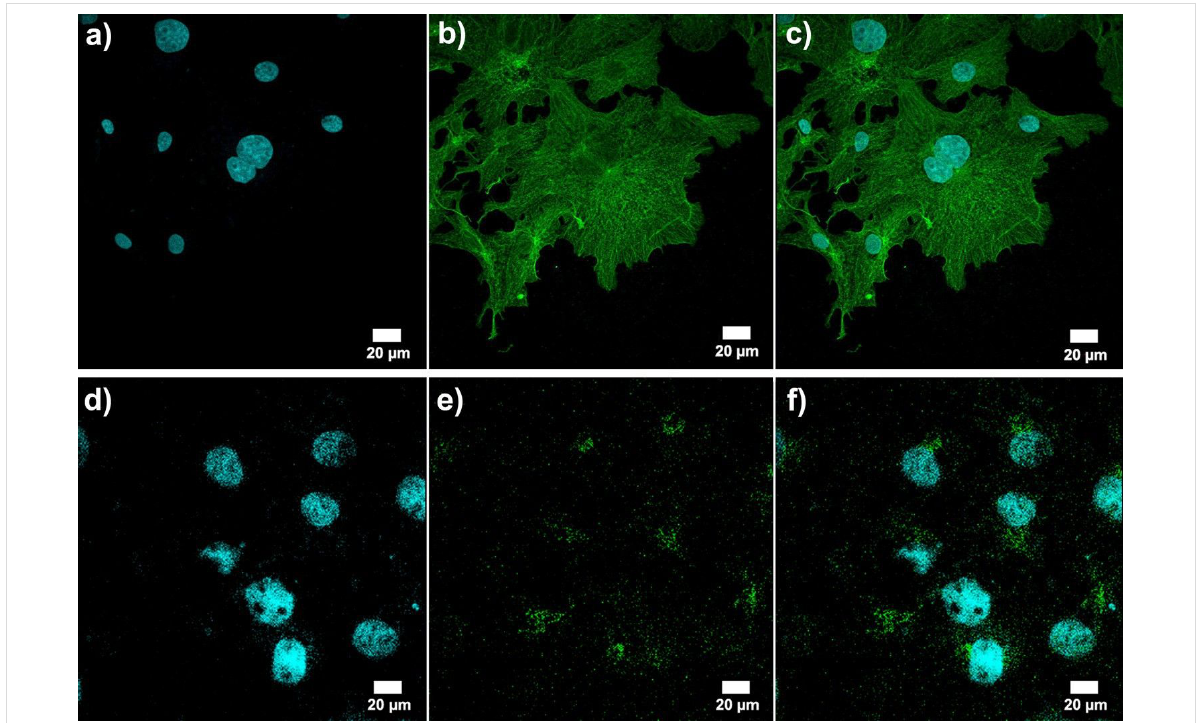
Figure 5: Normally proliferating BEAS2B cells on a dummy chip in LTCC package. (a–c) the cells grow on top of the chip. (d–f) The cells grow on top of LTCC. In (a) and (d), the blue color indicates the cell nuclei stained with a DNA binding dye, Hoechst 33342. In (b) and (e), immunofluorescence staining was performed with anti- α -tubulin antibody and Alexa 488 secondary antibody. The green color shows the microtubules of the cell cytoskeleton. In (c) and (f), the merged image of the nuclear staining and cytoskeleton are shown. The images were taken with a Zeiss LSM700 confocal microscope with 63× plan-apo immersion objective and appropriate filter sets.